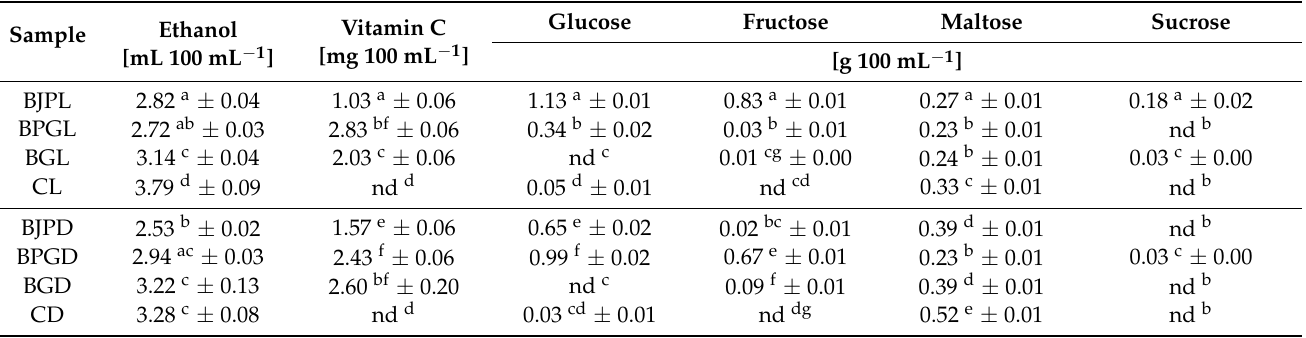
Table 3. Average results of physicochemical analyses (ethanol, vitamin C, and sugars) in study beer beverages after the re-fermentation